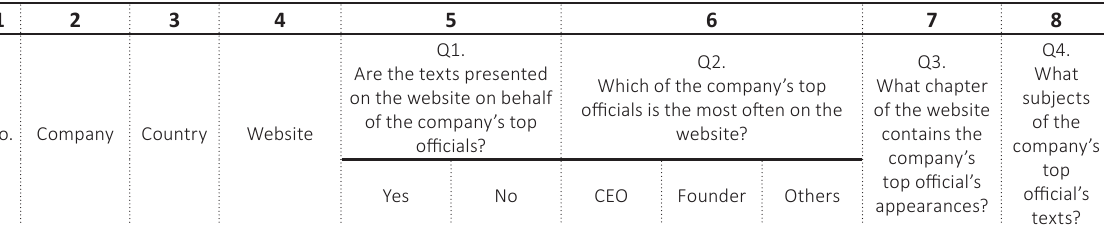
Table 1. The content analysis